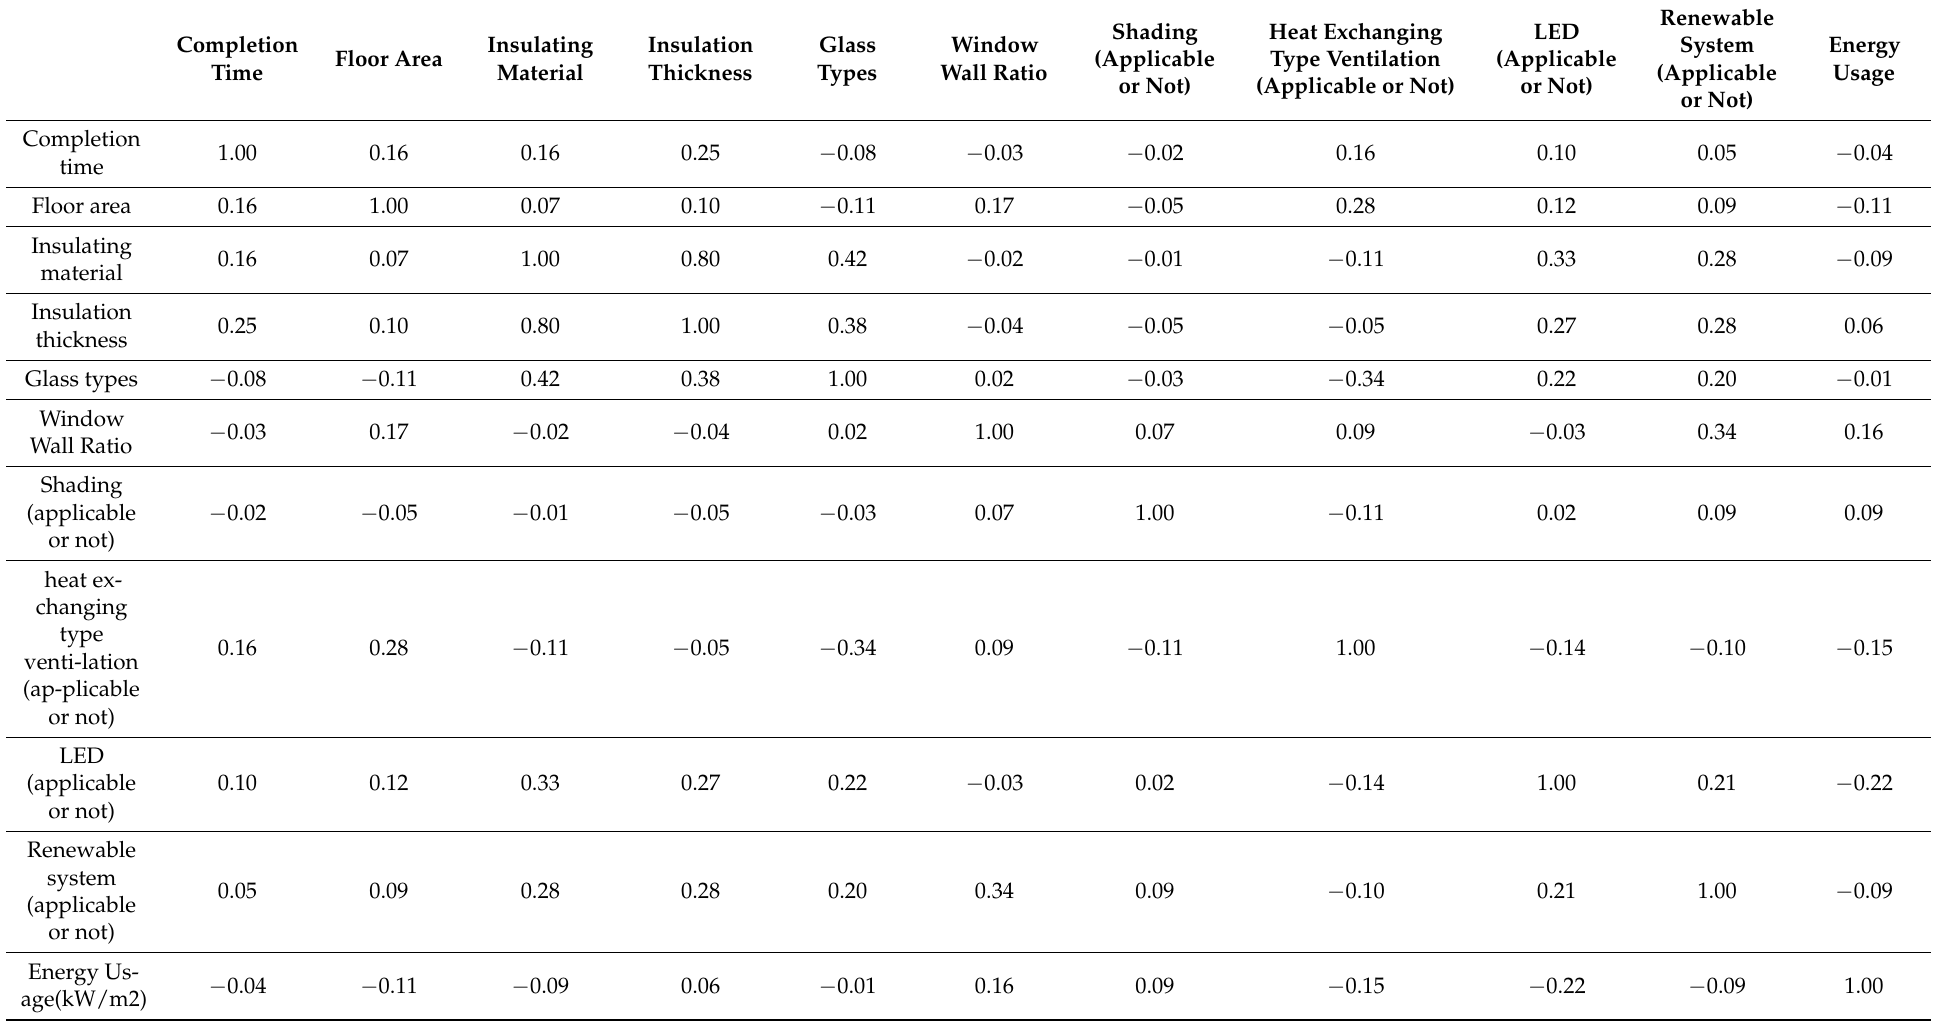
Table 11. A table showing the results of analyzing the correlation between the amount of energy usage and the green remodeling implementation